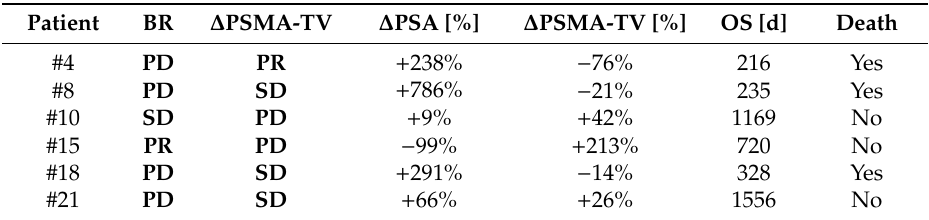
Table 5. Relative changes in PSA, ∆ PSMA-TV (Syngo.via) and overall survival (OS) in six patients with clinically relevant disagreement between PSMA-TV and BR (non-PD vs. PD classification). PR: